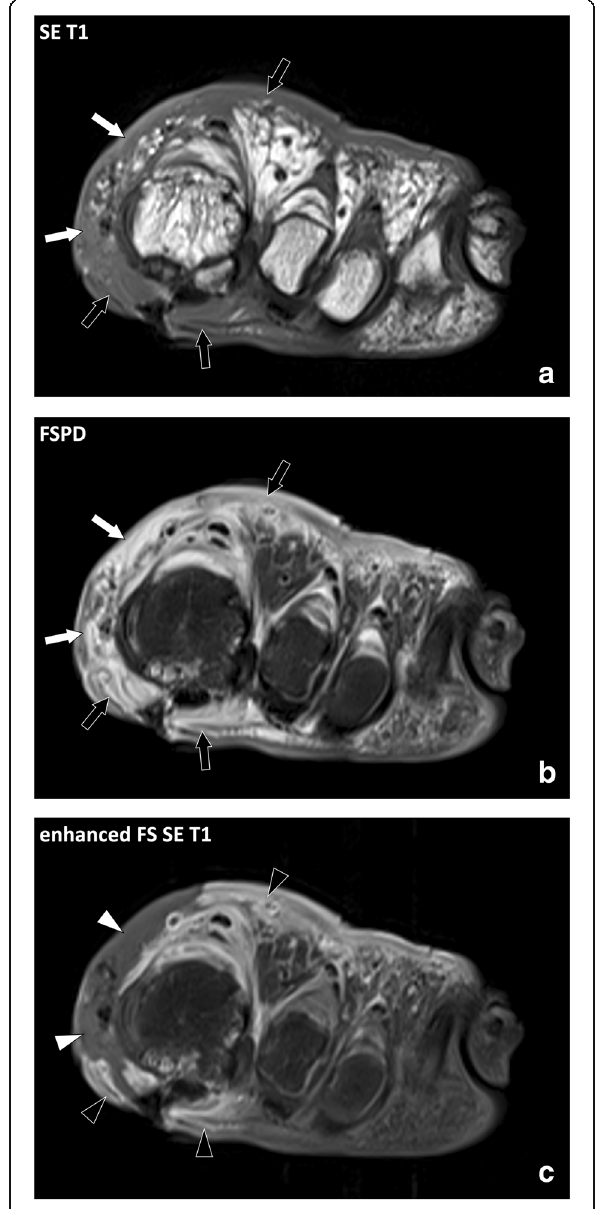
Fig. 9 Coronal ( a ) SE T1w, ( b ) FSPD, and ( c ) contrast-enhanced fat- suppressed T1w images of the left forefoot of an 81-year-old diabetic male with foot ulcer and necrotizing cellulitis. SE T1w and fluid-sensitive images demonstrate infiltrated hypodermic fat on the medial (white arrows) and to a lesser account dorsal aspect (black arrows) of the foot while the hypodermic fat on the plantar and lateral aspect is normal. After contrast material injection, necrotized skin and fat do not enhance (white arrowheads) and are surrounded by fat with enhanced inflammatory infiltration (black arrowheads)